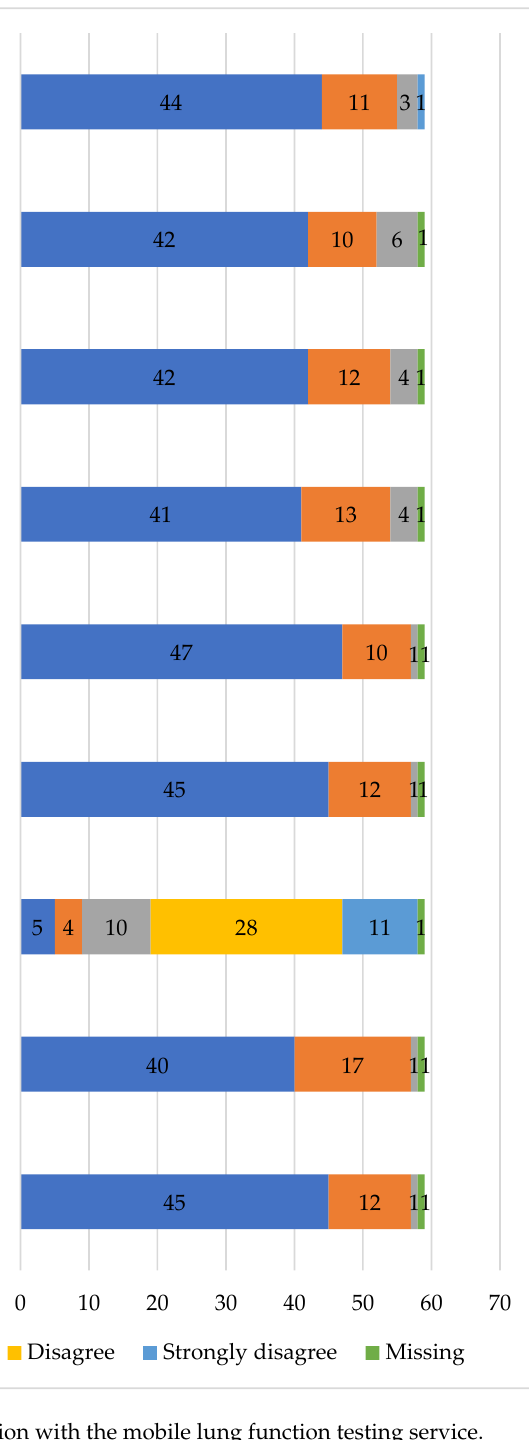
Figure 1. Participants’ satisfaction with the mobile lung function testing service.